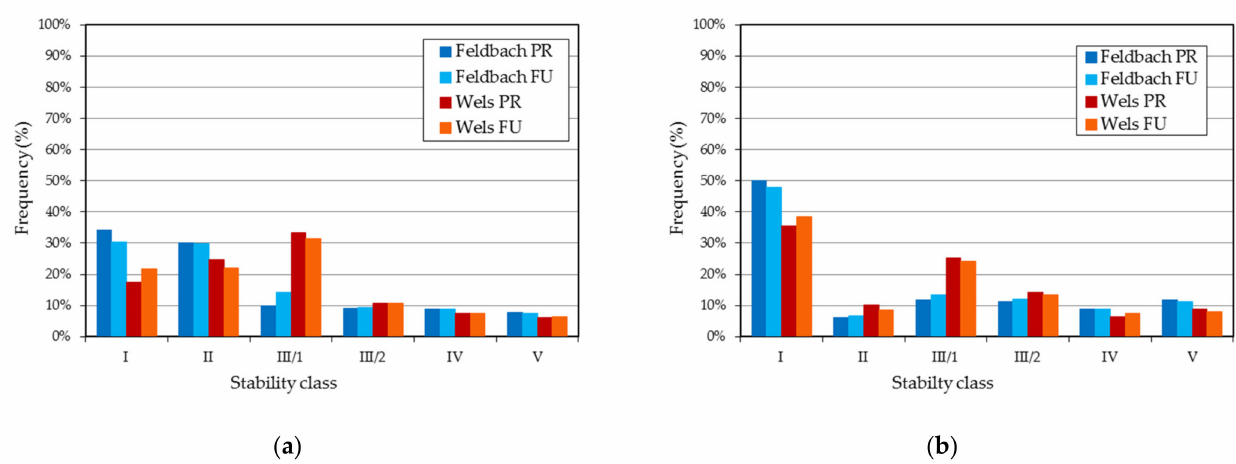
Figure 7. Frequency distribution of stability classes determined by ( a ) cloudiness and wind speed (VDI method, Table 2) and ( b ) radiation balance and wind speed (KTA method, Table 3) at Feldbach and Wels (PR—present (1981–2010); FU—future (2036–2065)) (taken from